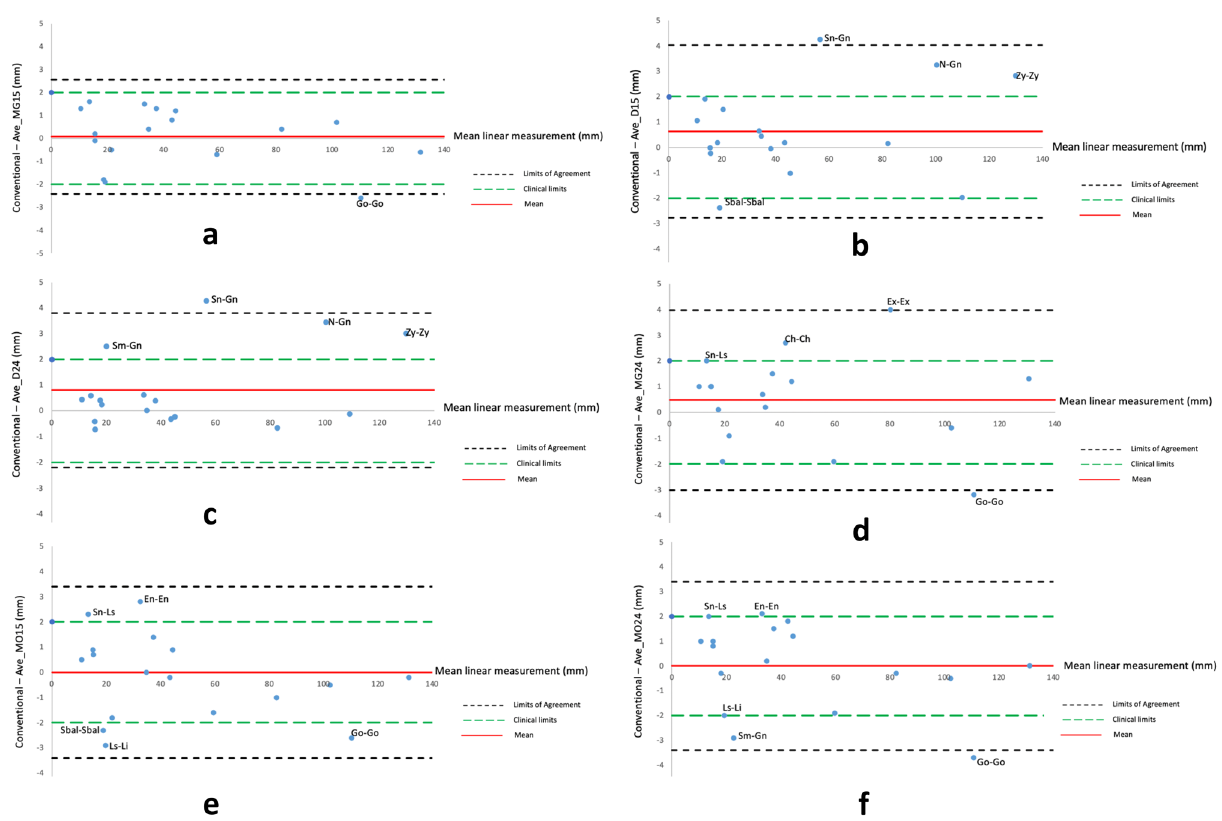
Figure 6. Bland–Altman plots showing agreement between linear measurements obtained from conventional digital anthropometry and from the ( a) Ave_MG15, ( b) Ave_D15, ( c) Ave_D24, ( d) Ave_MO24, ( e) Ave_MG24, ( f) Ave_MO15